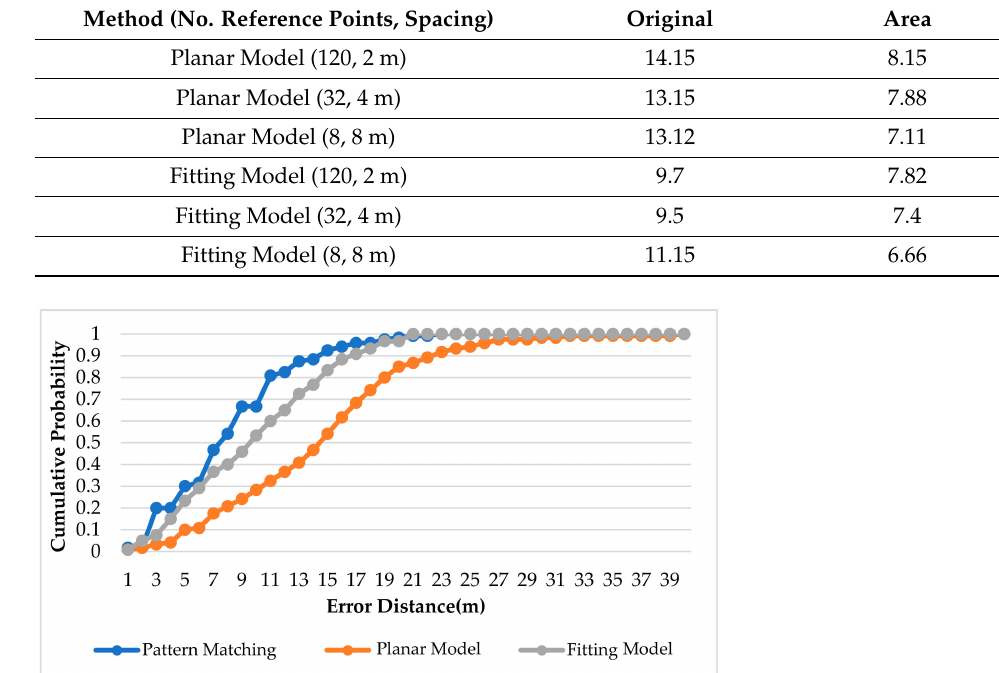
Figure 21. CDF for Original Data in Basketball Court.